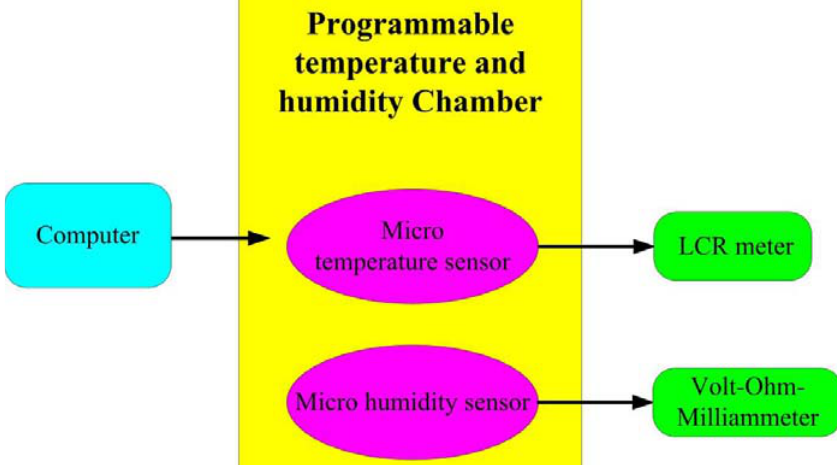
Figure 6. Temperature and humidity calibration